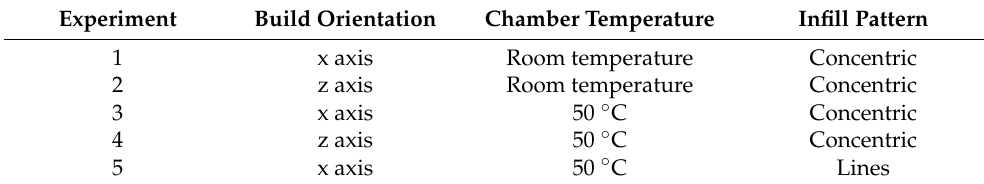
Table 1. Summary of the conditions used in the experiments.